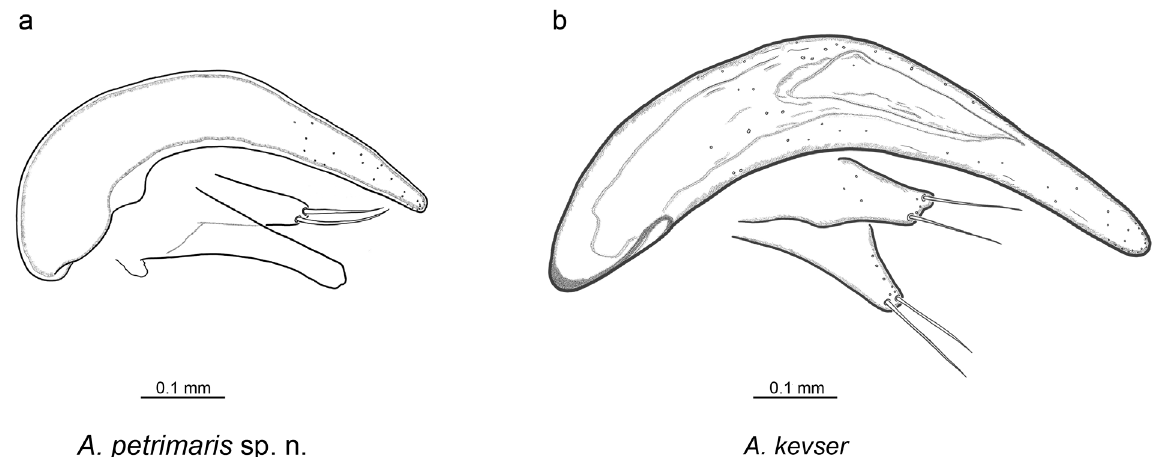
Figure 8. Male genitalia of Adriaphaenops petrimaris sp. n. (a) and similarly looking A. kevser (b) (illustrations by Fedor